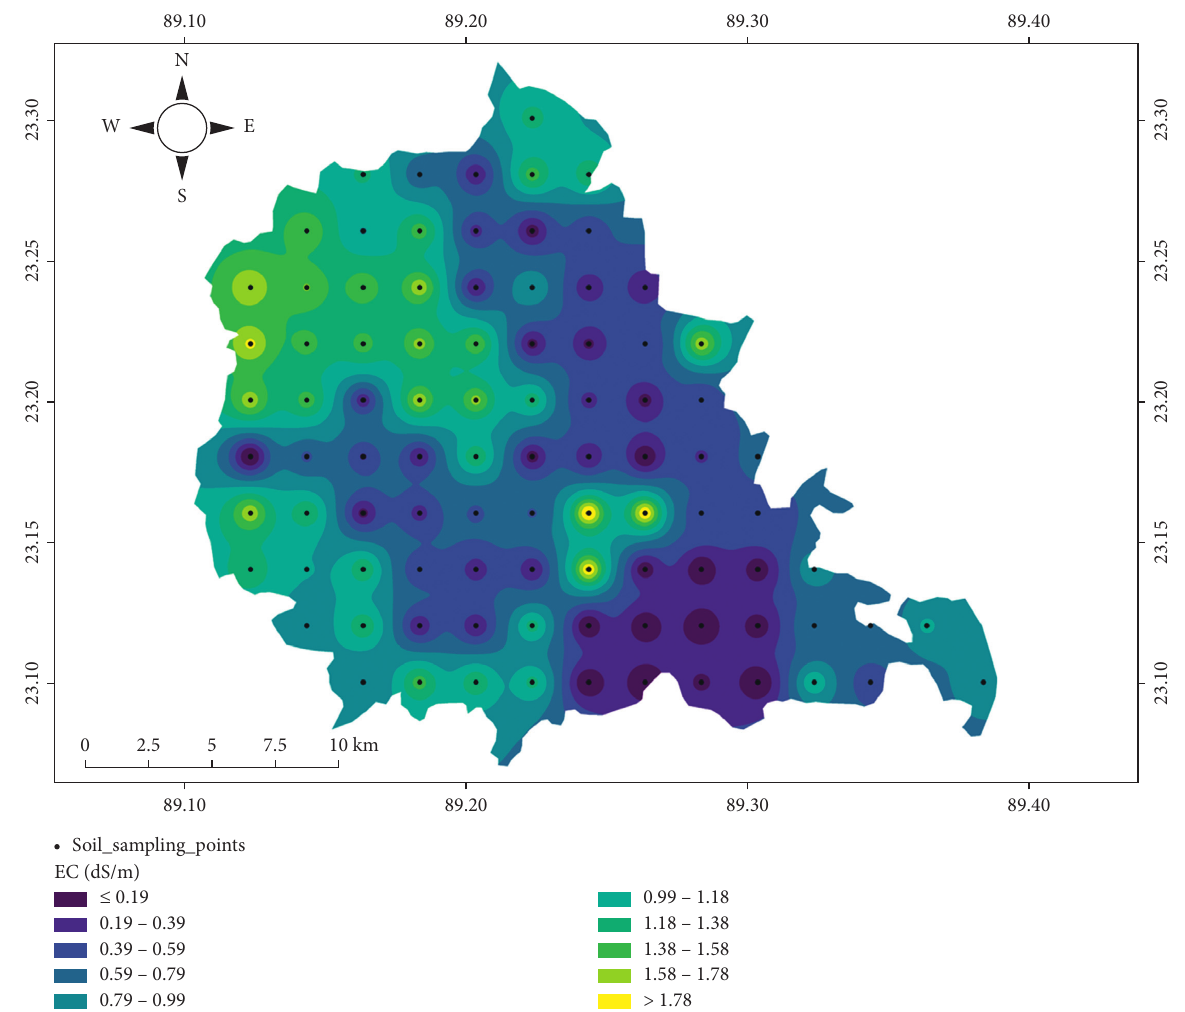
Figure 6: Spatial distribution of soil electrical conductivity (EC) contents in the study